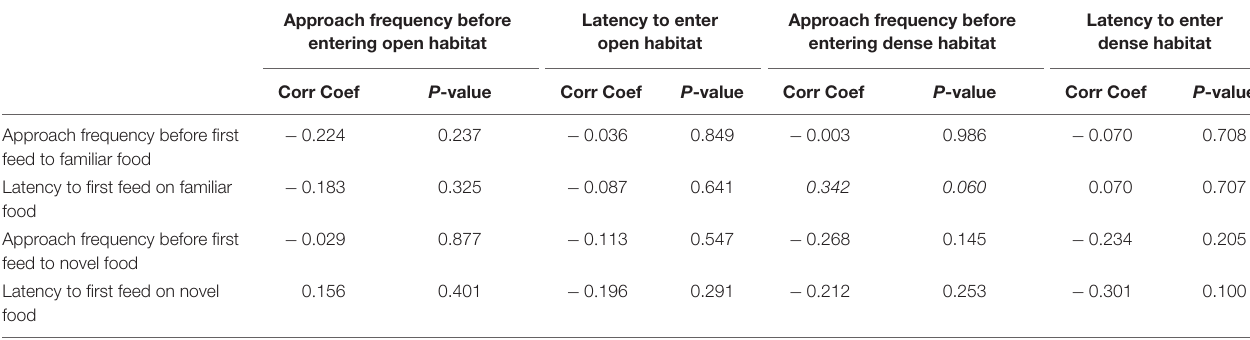
TABLE 1 | Correlation between food neophobia measures and spatial novelty reactions. Approach frequency before entering open